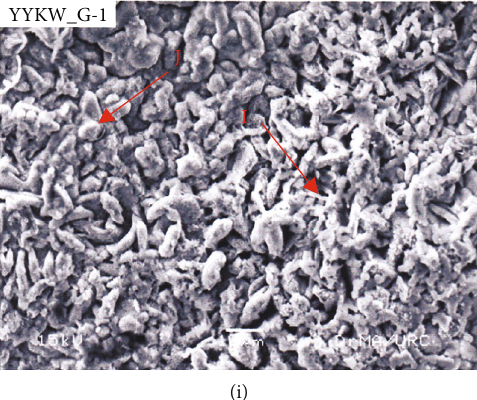
Figure 6: The morphology of corrosion products: (a) after one month: plate (A) and globular (B) lepidocrocite; (b) after two months: bar type lepidocrocite; (c) after four months: akaganeite; (d) after fi ve months: magnetite. The morphology of corrosion products: (e) after six months: sandy crystals (C) and bar-shaped (D) lepidocrocite; (f) after seven months: sandy crystals lepidocrocite; (g) after eight months: sandy crystals (E) and fl owery (F) lepidocrocite; (h) after nine months: globular (G) and needle-shaped goethite on the surface of globular (H) lepidocrocite; (i) after twelve months: worm net lepidocrocite (I) and cotton ball goethite